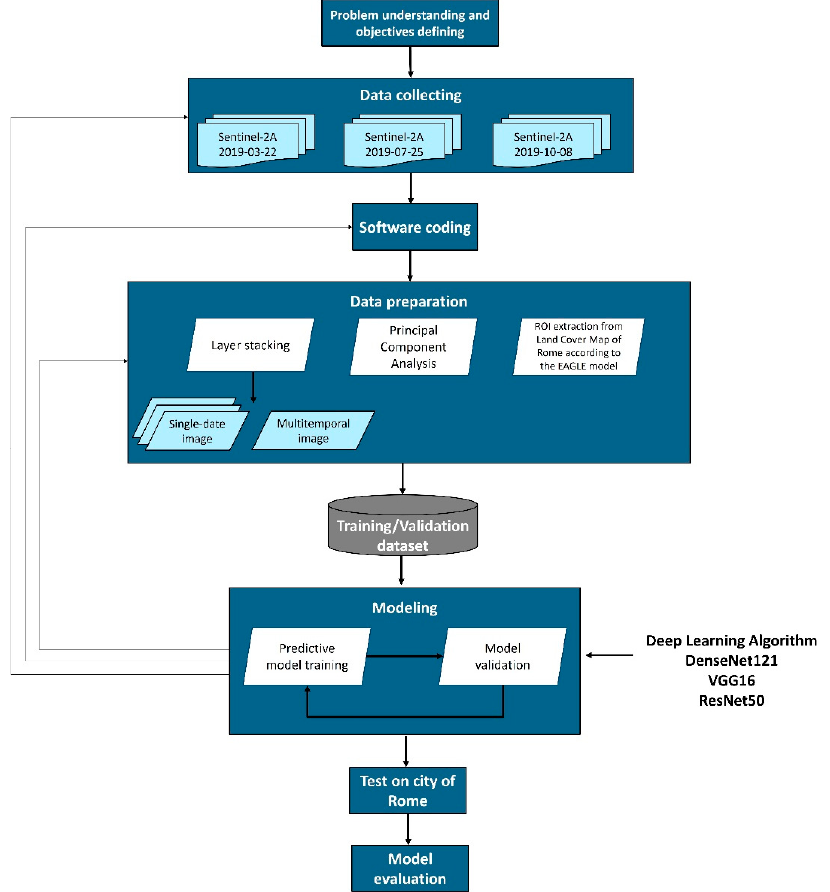
Figure 3. Study work fl ow.